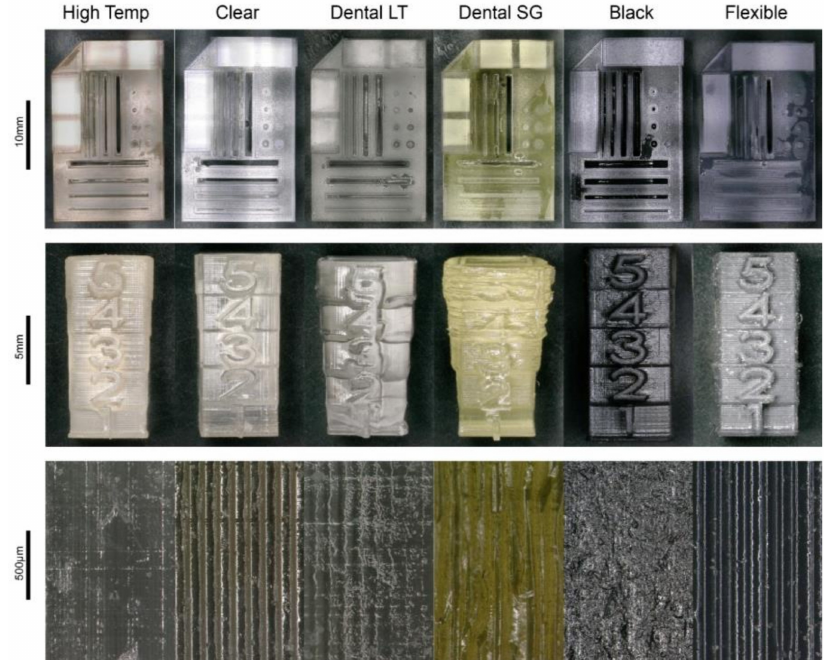
Figure 1. Results of the 3D prints of the photopolymers High Temp, Clear, Dental LT, Dental SG, Black, and Flexible. Top: test print for evaluation of the reproducibility of printing complex features. Centre: test print for evaluation of the level of detail. Bottom: optical enlargement of the surface structure of the di ff erent photopolymers.